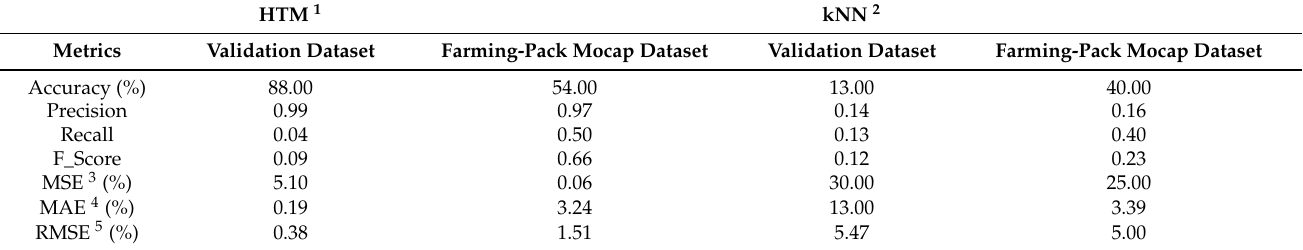
Table 2. Performance metrics evaluation for the validation dataset and Farming-Pack mocap